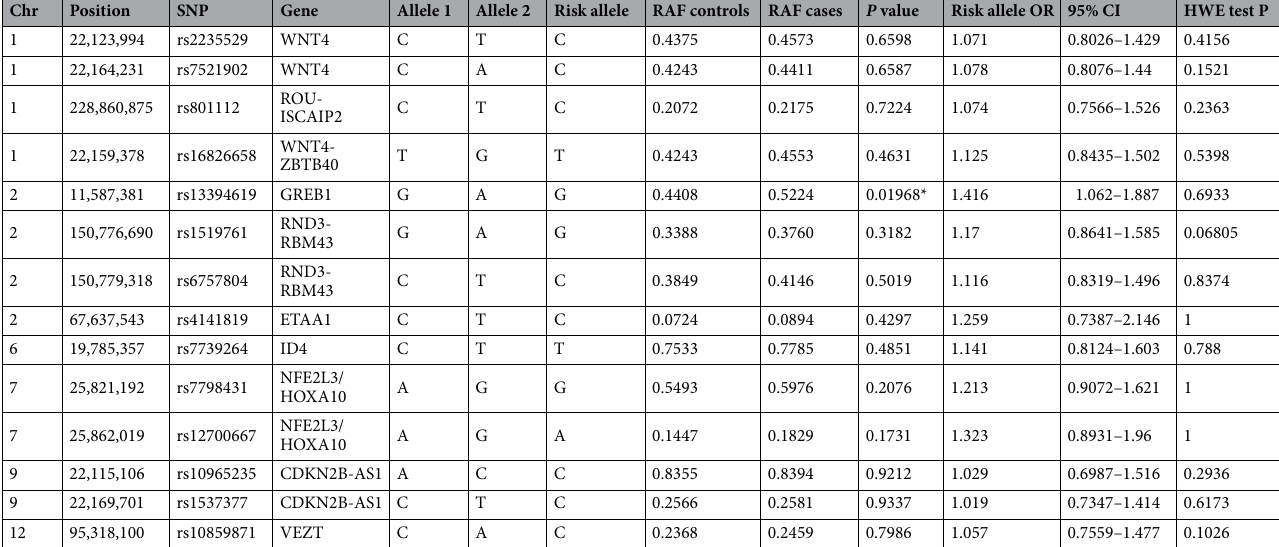
Table 5. Replication of endometriosis-associated single-nucleotide polymorphism from previous genome- wide association studies (Endometriosis, n = 241, controls, n = 156). RAF risk allele frequency, Trend P P vale of Trend test, OR odds ratio, CI confidence interval, HWE test P Hardy–Weinberg equilibrium test P value of controls. *indicates P <